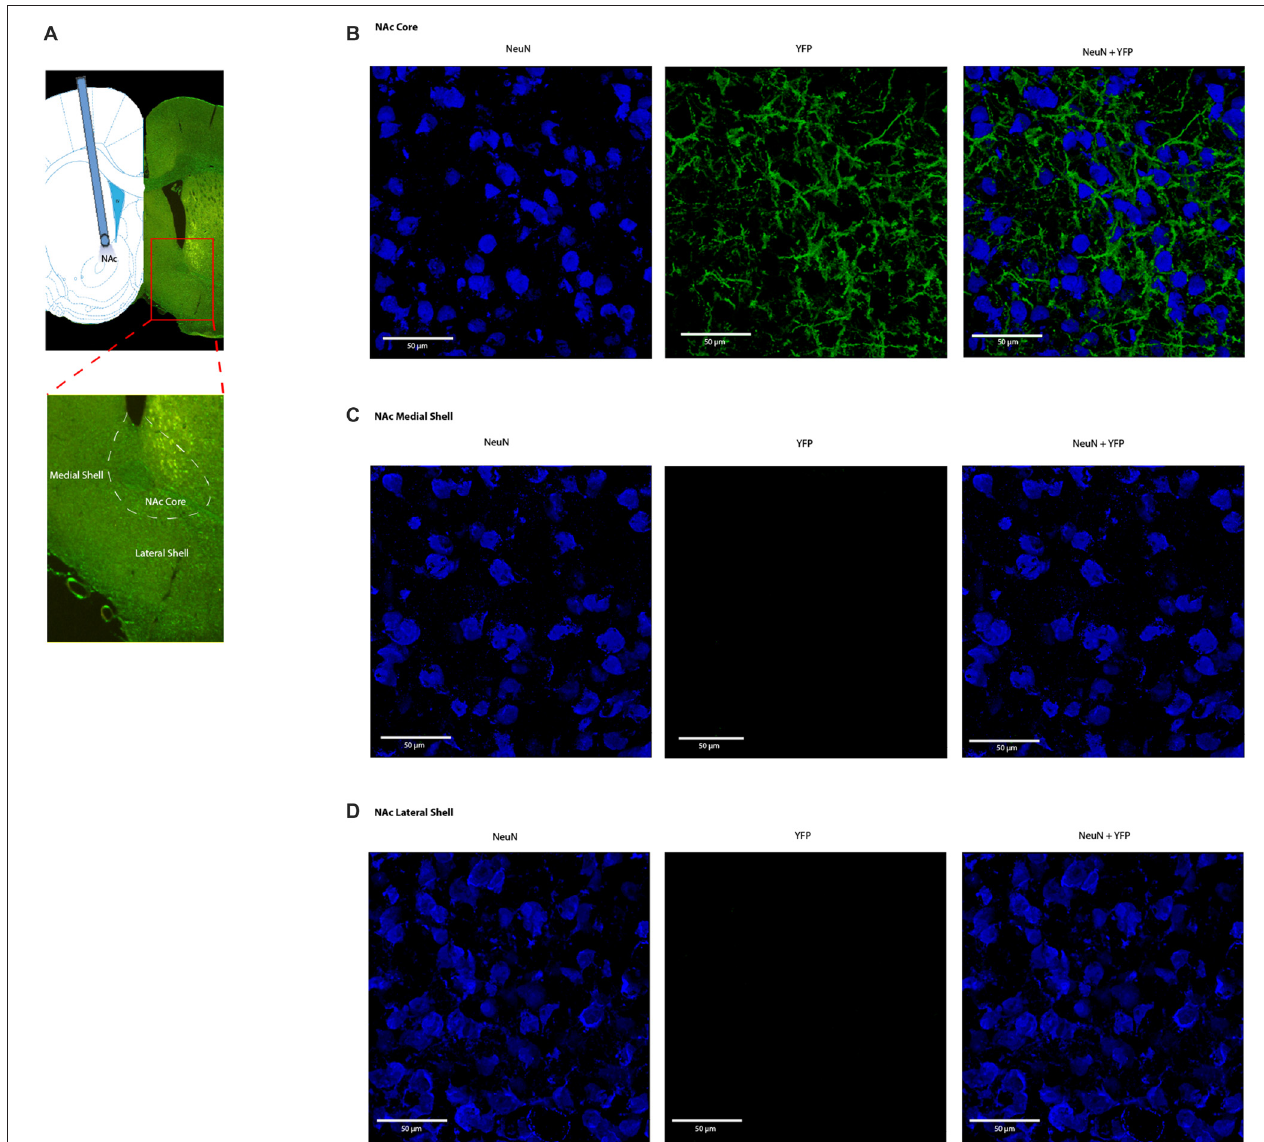
FIGURE 5 | Expression of ChR2-eYFP in the axon terminals of prefrontal neurons that project to the nucleus accumbens (NAc) core. (A) Representative brain slice showing ChR2-eYFP expression in the NAc core 4 weeks after PL-PFC injection. (B) Higher magnification views demonstrating expression of ChR2 in prefrontal neurons that project to the NAc core. (C,D) Higher magnification views demonstrating a lack of opsin expression in the NAc medial and lateral